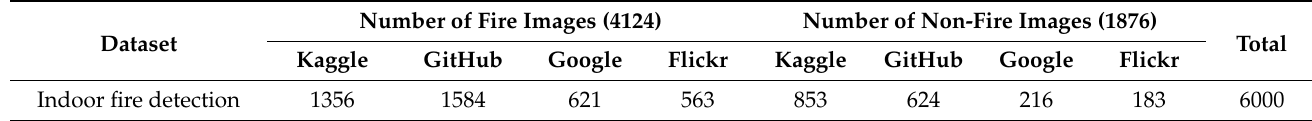
Table 1. Image sources for fire detection